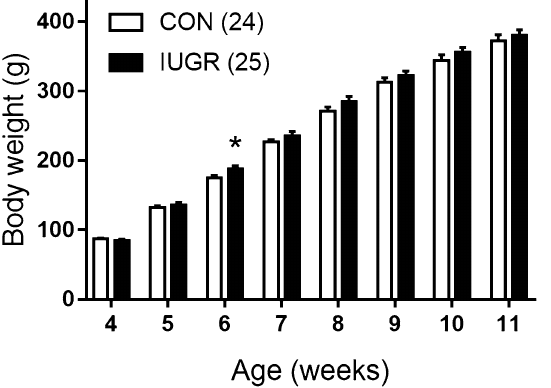
Figure 2. Body weight of male offspring from control and IUGR groups. Numbers in parenthesis indicate the number of animals. *p < 0.05 (unpaired Student’s t test).